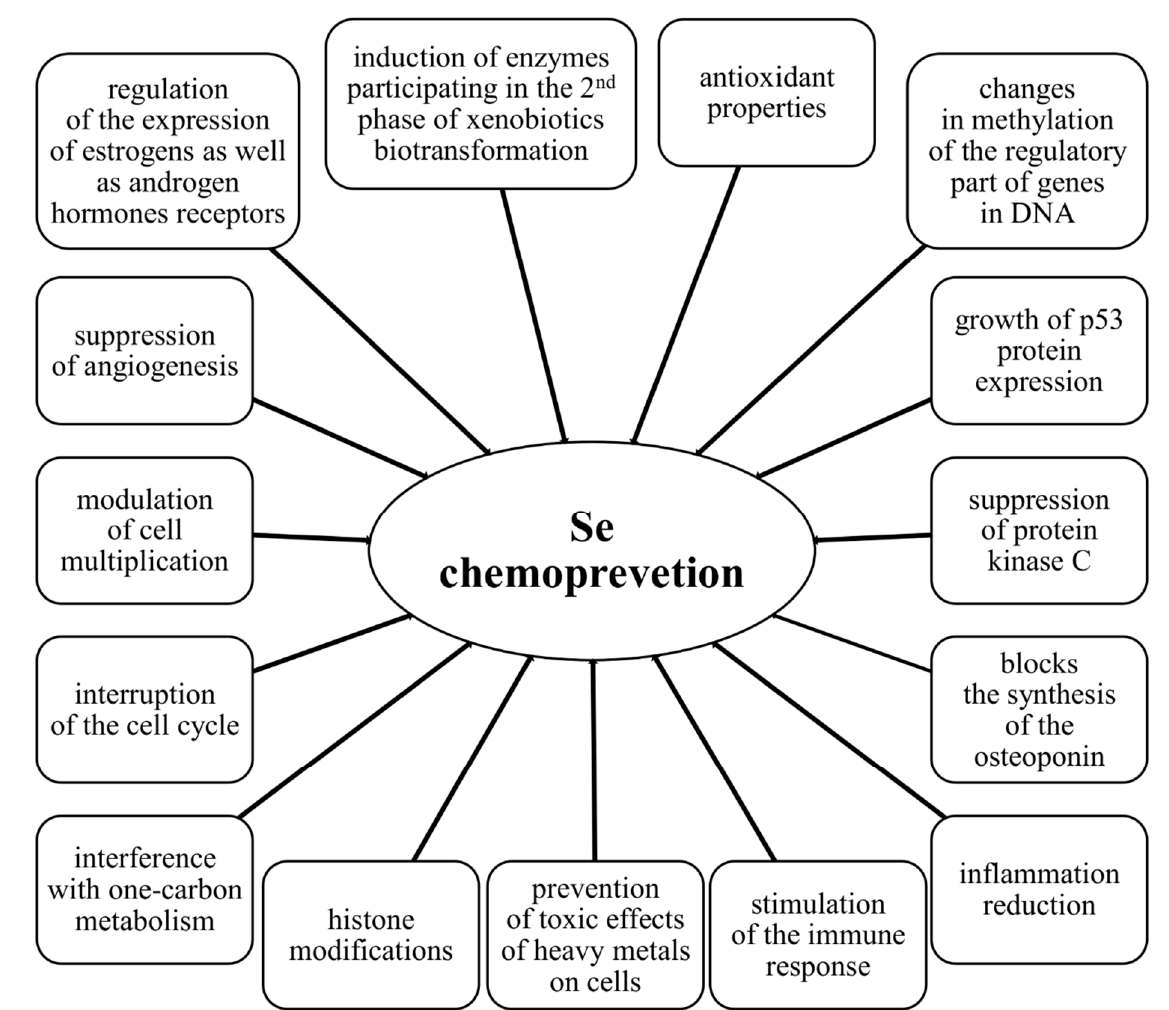
Figure 7. Possible mechanisms of cancer chemoprevention by selenium.